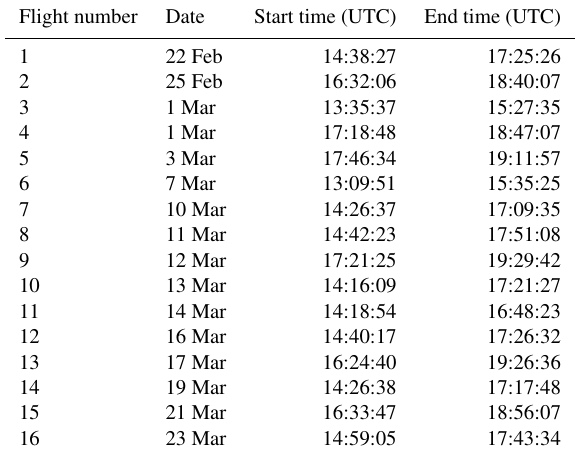
Table 1. Dates and times for all G-1 flights during GoAma- zon2014/5 IOP1. Local time for Manaus is UTC − 4. All flights were carried out in the year